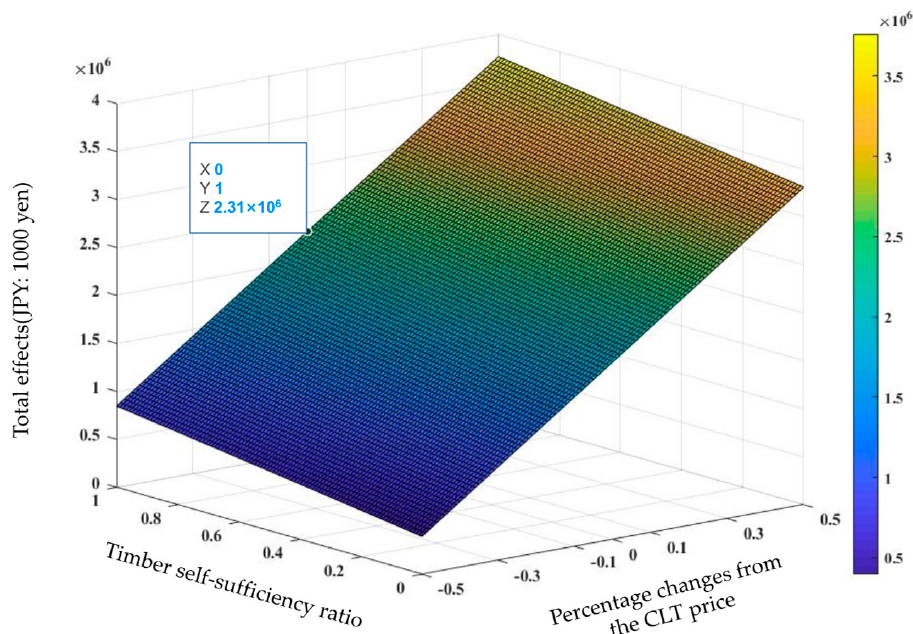
Figure 8. Impact of changes in the domestic self-sufficiency ratios for the timber and CLT price on the total effect. The labels indicate the total effects corresponding to the CLT sector in this study.